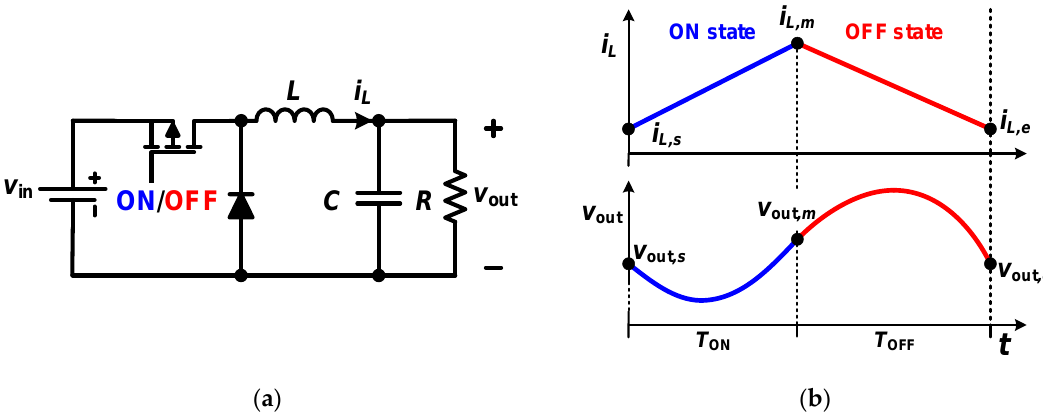
Figure 1. Buck converter: ( a ) Circuit scheme and ( b ) inductor current and output voltage during switching-ON and switching-OFF.